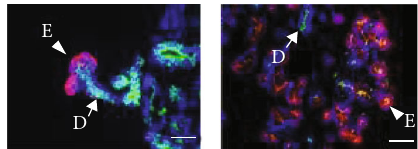
Figure 2: Immuno fl uorescence images of salivary gland organoid derived from mouse PCSs (a) and mouse embryonic salivary gland E18 (b). The ductal marker K18 (green) and the acinar cell marker AQP5 (red) were shown. Scale bars, 50 μ m. Arrows indicate ducts (d). Arrowheads indicate an epithelial bud (e) (immuno fl uorescense images taken from Tanaka et al.